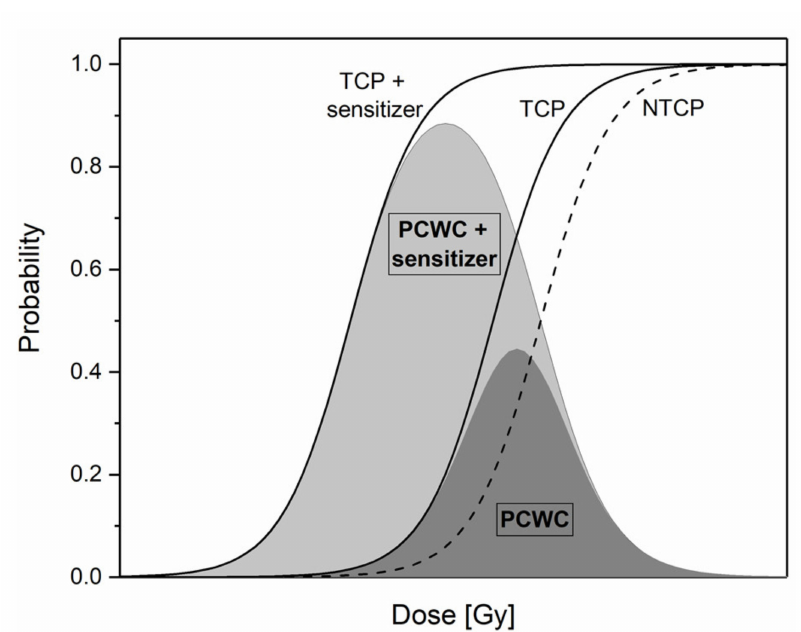
Figure 1. Schematic representation showing the action of tumor-targeted radiosensitizer on the probability of cure without complication (PCWC). The tumor control probability (TCP, solid line) and normal tissue complication probability (NTCP, dashed line) are shown as a function of the dose delivered to the patient. Two scenarios are illustrated with or without the use of a radiosensitizer and the associated PCWC is shown by the surface in each case. Adapted from